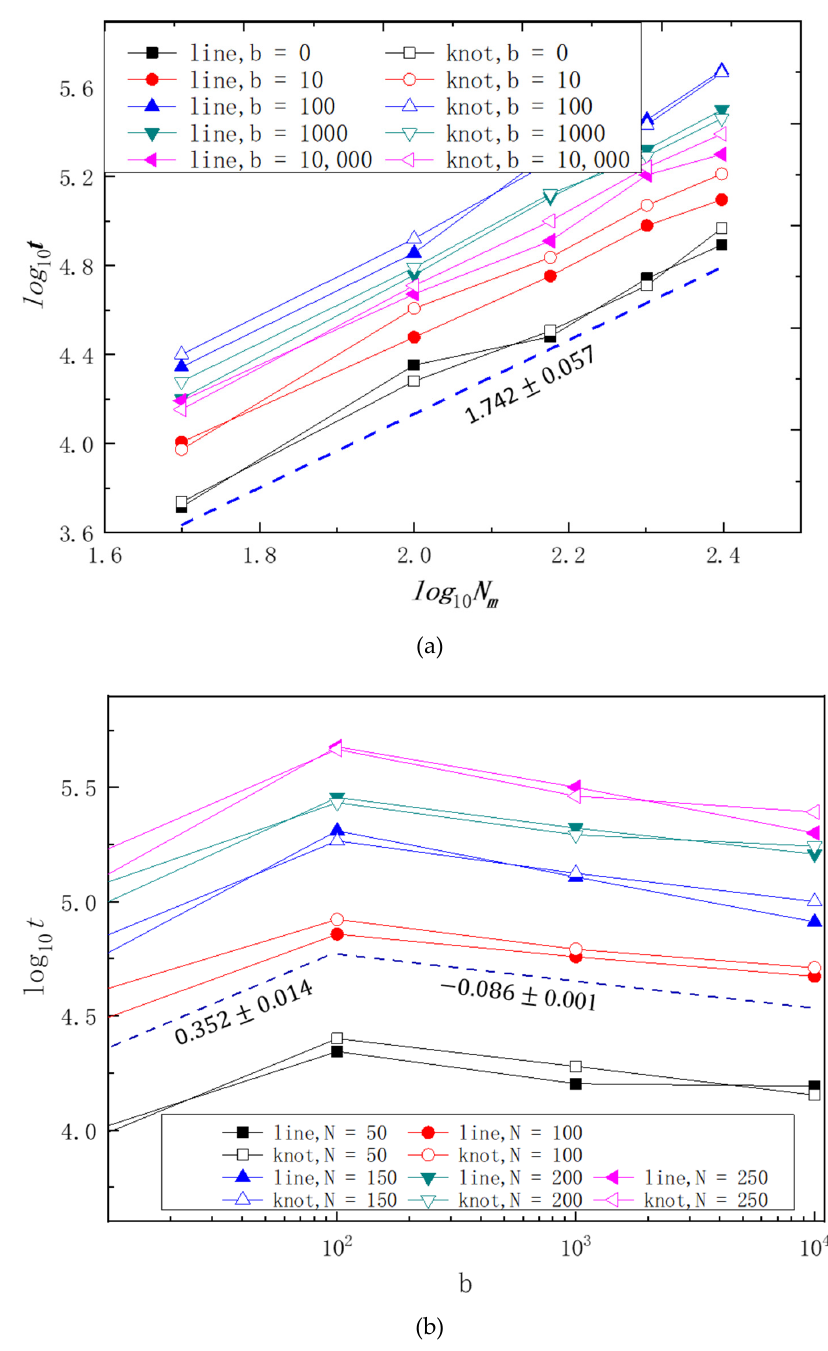
Figure 7. ( a ) Translocation time t as a function of polymer chain length N m . ( b ) Translocation time t as a function of bend parameter b. The filled symbols indicate the linear chain, and the hollow symbols represent the 3 1 knot chain.